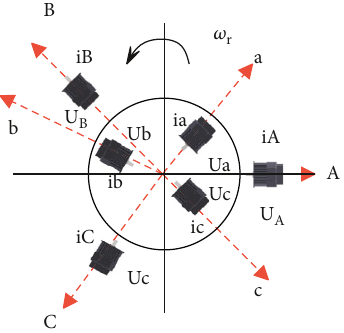
Figure 1: Three-phase induction motor